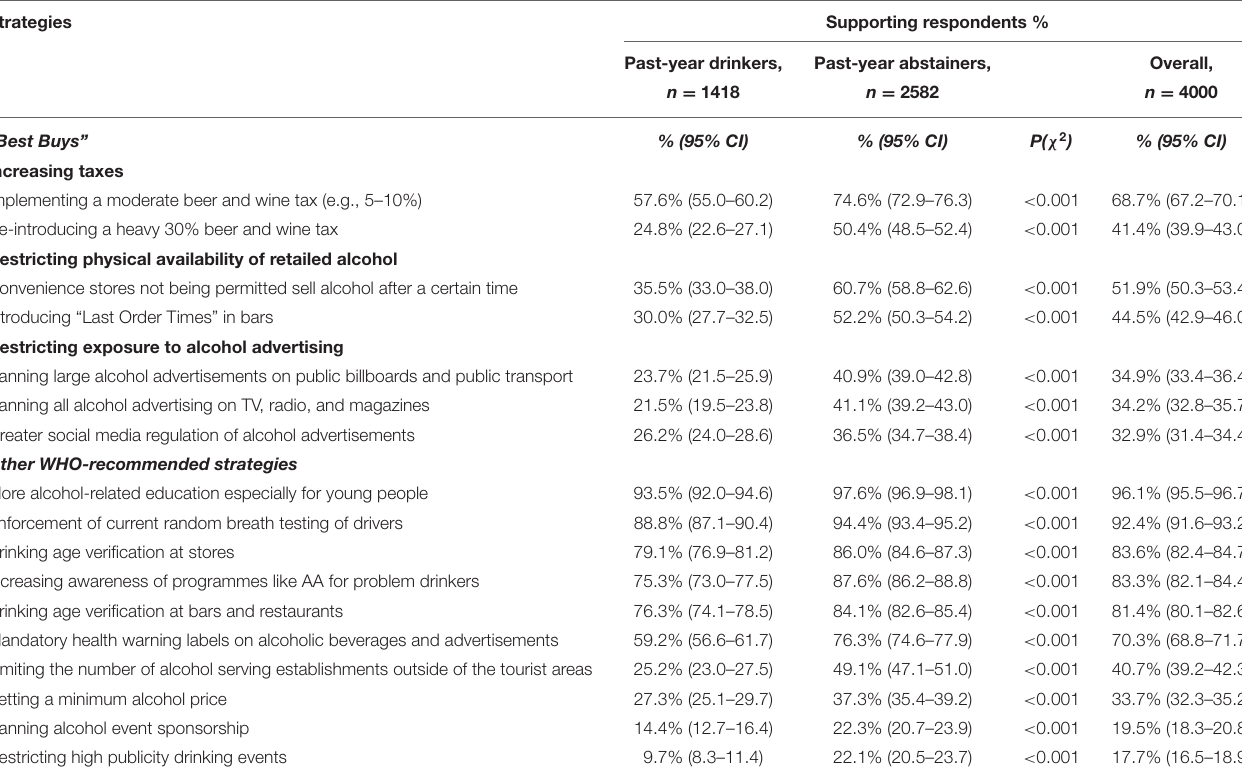
TABLE 2 | Endorsement of various alcohol harms reduction strategies, by past-year drinking status ( n = 4,000). Strategies Supporting respondents % Past-year drinkers, Past-year